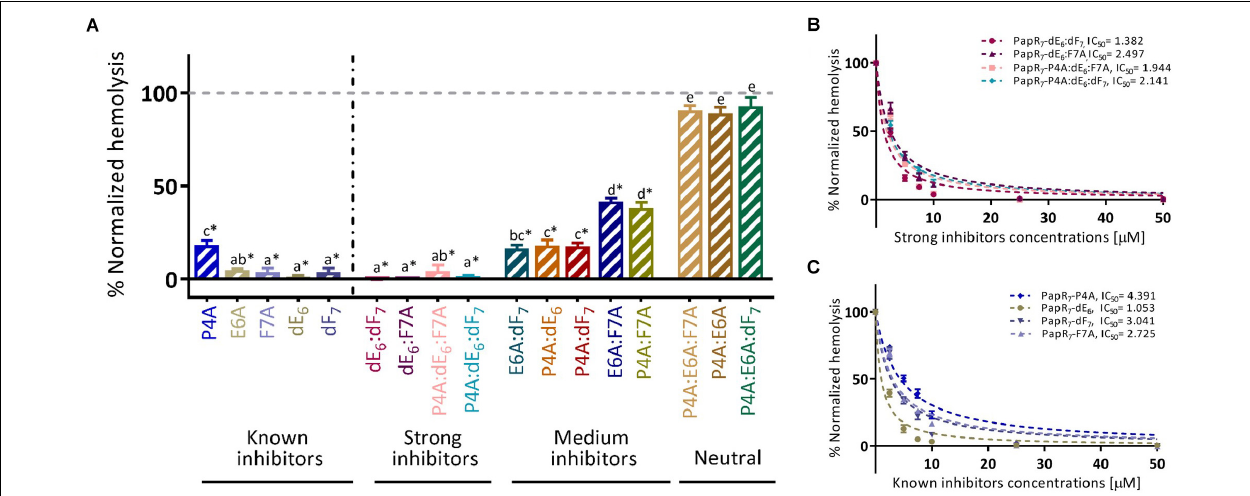
FIGURE 5 | New PapR 7 -derived peptide combinations inhibit Bc virulence factor. (A) Hemolytic activity on human red-blood cells of supernatant B. cereus ATCC 14579 treated cultures in 10 µ M of PapR 7 -derived peptides normalized to untreated bacterial cells at end lag phase of bacterial growth (OD 600 of 0.1 ± 0.03; mean ± SEM, n = 9). Hemolysis inhibition dose response curves of B. cereus ATCC 14579 treated supernatant cultures in different concentrations of (B) PapR 7 – dE 6 :dF 7 , dE 6 :F7A, P4A:dE 6 :dF 7 , and P4A:dE 6 :F7A and (C) known inhibitors normalized to untreated bacterial culture (mean ± SEM, n = 9). ∗ p < 0.01 indicates a statistically significant difference between untreated B. cereus ATCC 14579 and addition of PapR 7 -derived peptides. Different letters indicate statistically significant differences between PapR 7 -derived peptide treatments ( p < 0.01).